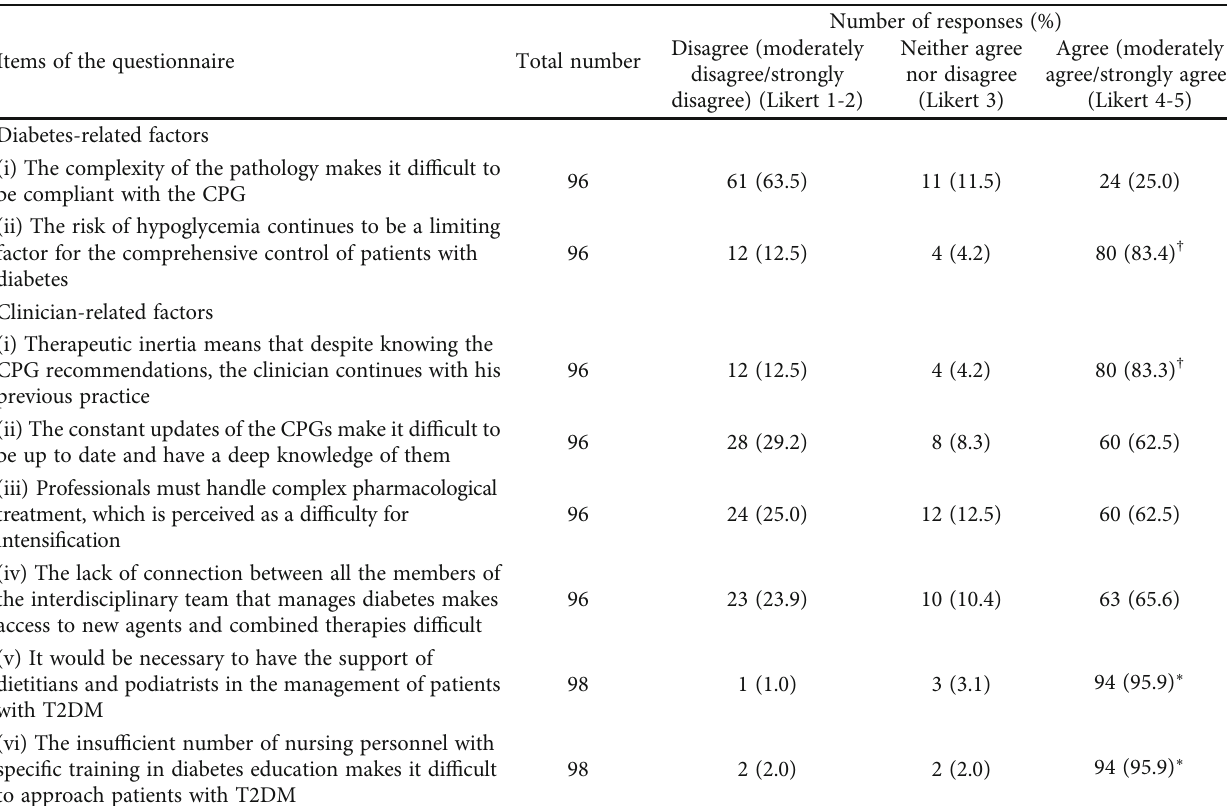
Table 3: Factors related to diabetes and the